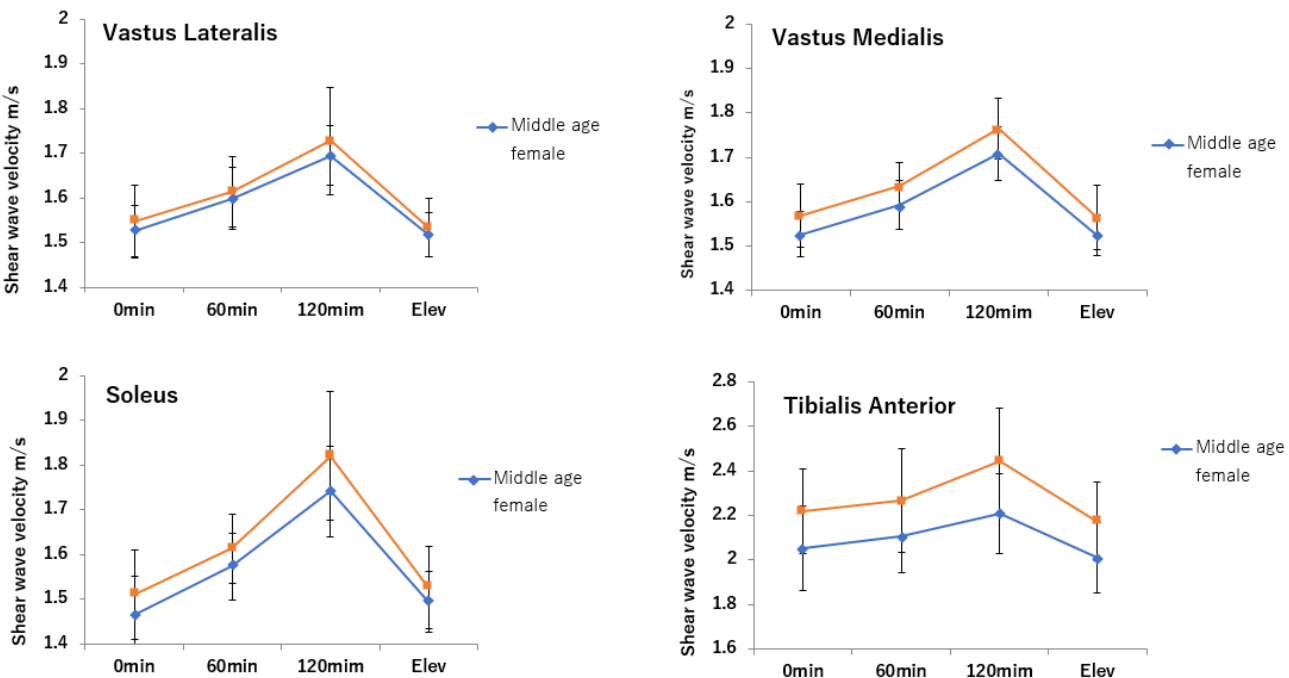
Figure 7. Shear wave velocity of LG, MG, SOL, and TA over time. Unit: m/s. Average ± SD. LG: Lateral gastrocnemius; MG: Medial gastrocnemius; SOL: Soleus; TA: Tibialis anterior.